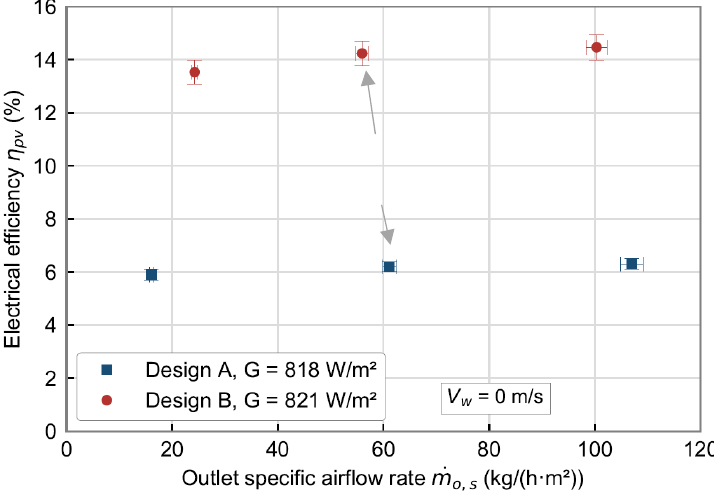
Figure 21. Electrical efficiency comparison as a function of the outlet specific airflow rate.